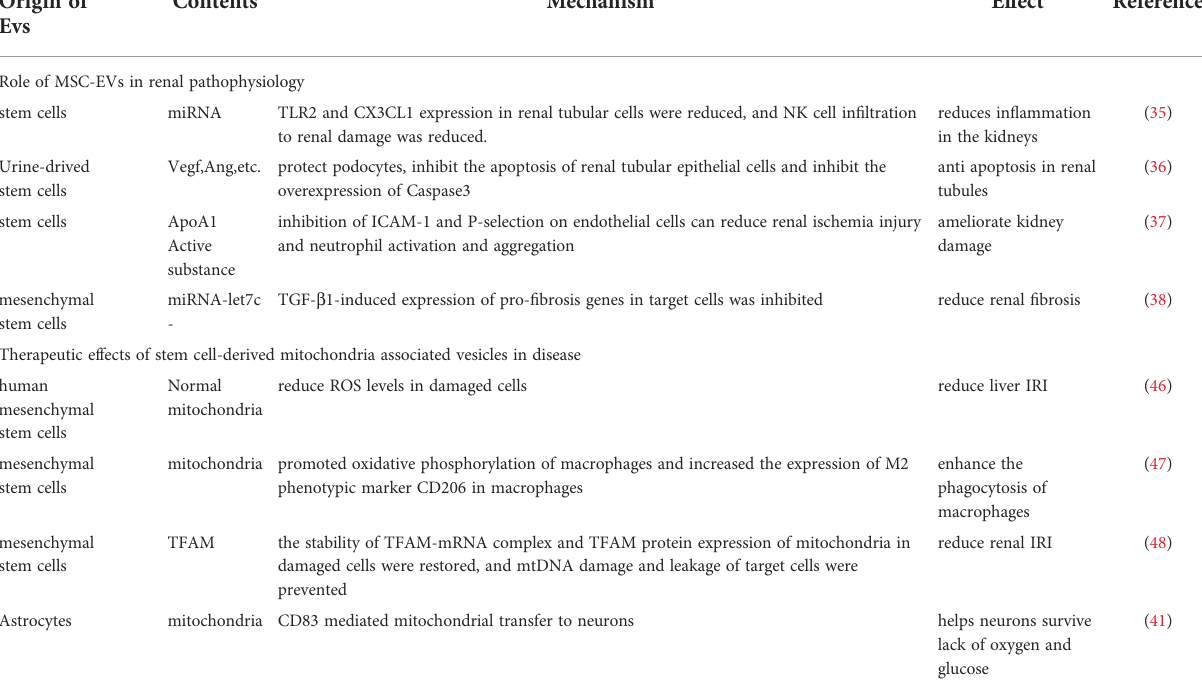
TABLE 1 Role of extracellular vesicles in a variety of pathoophysiological process. Origin of